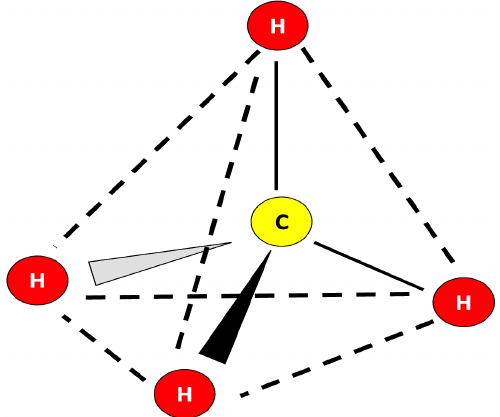
Figure 1. A sketch of a tetrahedral carbon atom model. Alexander Butlerov coined the phrase “molecular structure” in 1861, implying that any compound should have a rigid molecular composition. This phrase referred to a number of the compounds’ chemical features (for detail, see [5]). The line depiction of atomic bonds was originally used in [6] as a different interpretation paradigm. However, since these lines represented merely interatomic forces and not individual bonds, Couper’s work is credited with being the first graphical depiction of a chemical bond (see [7]). The molecular formula for acetic acid was established and represented chemically as a framework with geometric shapes linking the atoms in a molecule to symbolize chemical bonds (Figure 2). To learn more, the reader can refer to [8–10] and the references therein.